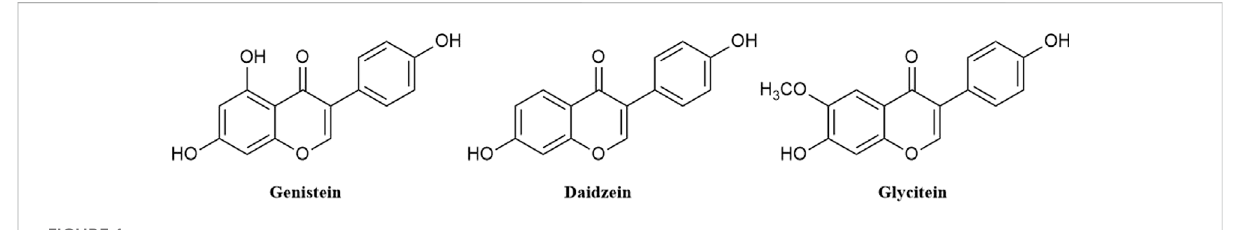
FIGURE 1 Structure of daidzein, genistein, and